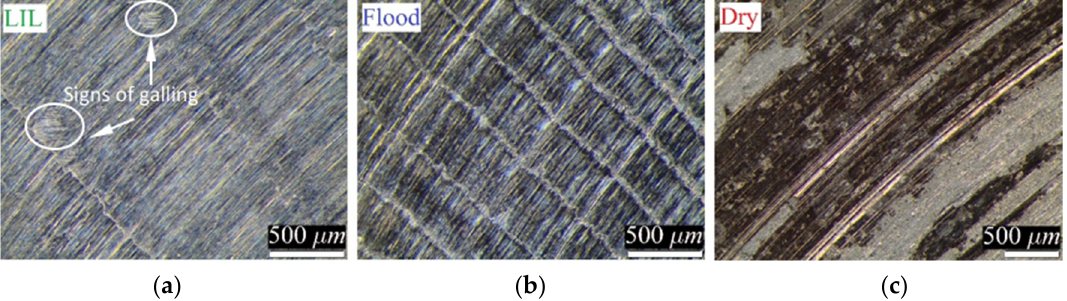
Figure 6. Cu-Ni wear tracks for different conditions: ( a ) LIL, ( b ) Flood and ( c ) Dry.